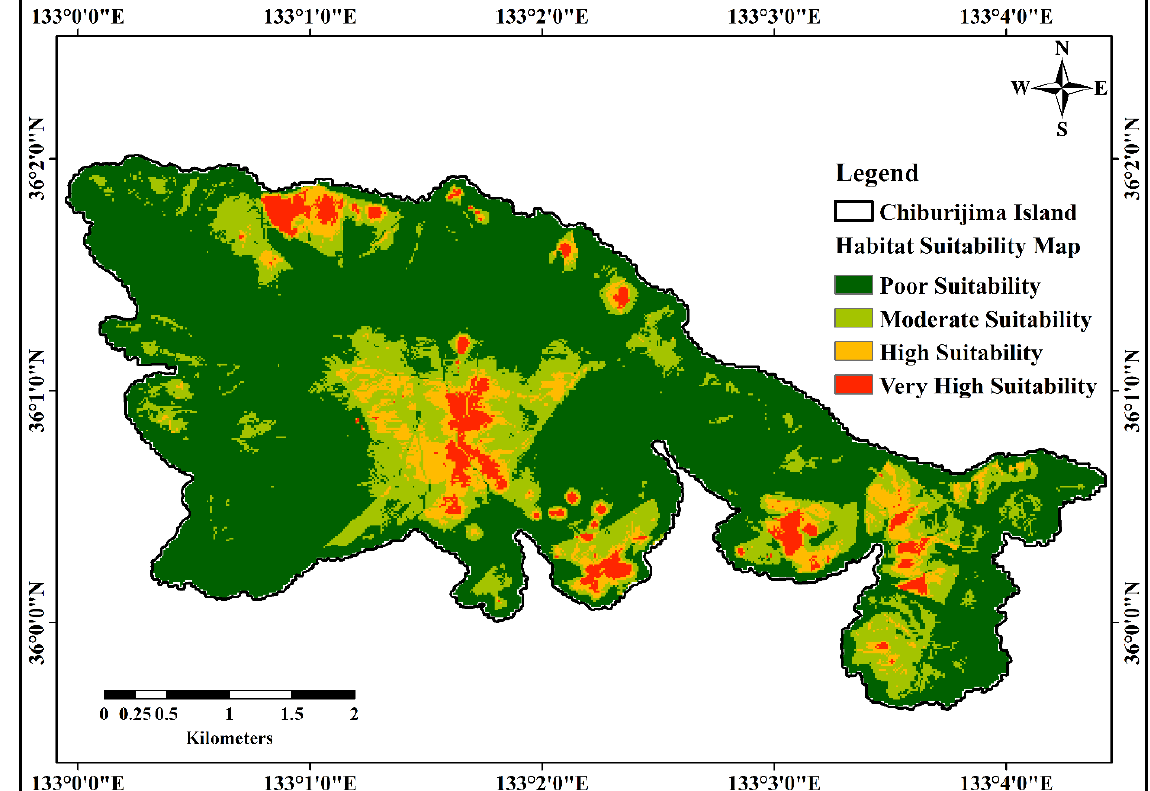
Figure 1. Habitat suitability map of predicted C. cordatum using MaxEnt model.